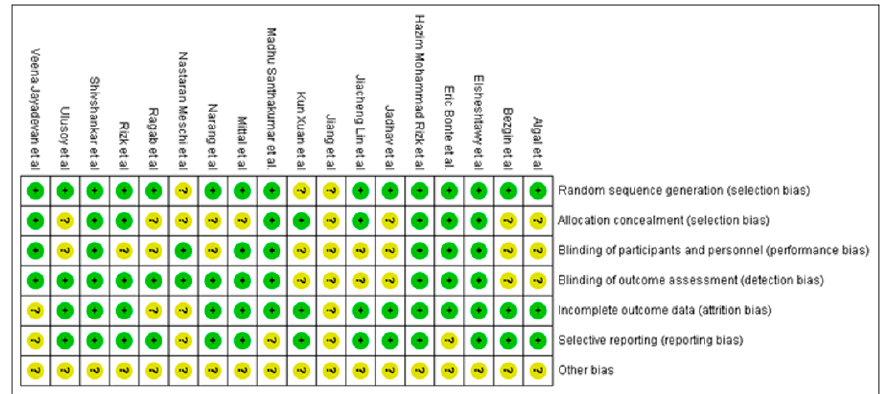
Figure 2. Quality assessment of included RCT studies summary: review authors’ judgements about each risk of bias item for each included study.